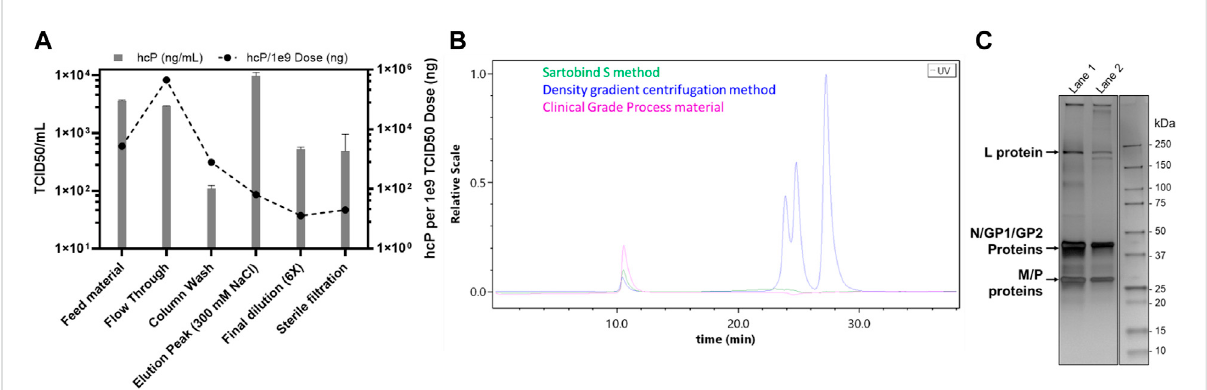
FIGURE 3 Host contaminant analysis for the puri fi cation of VSV-GP using Sartobind S membrane adsorber. (A) Host-cell protein ELISA for the various fractions collected during the puri fi cation of VSV-GP, (B) analytical SEC for the fi nal VSV-GP preparation as compared to that of puri fi ed using a density gradient centrifugation and clinical-grade process, and (C) SDS-PAGE analysis, comparing the VSV-GP puri fi ed, using: density gradient centrifugation (lane 1); and Sartobind S method (lane 2). The arrows show the respective viral proteins, L: large polymerase protein; N: